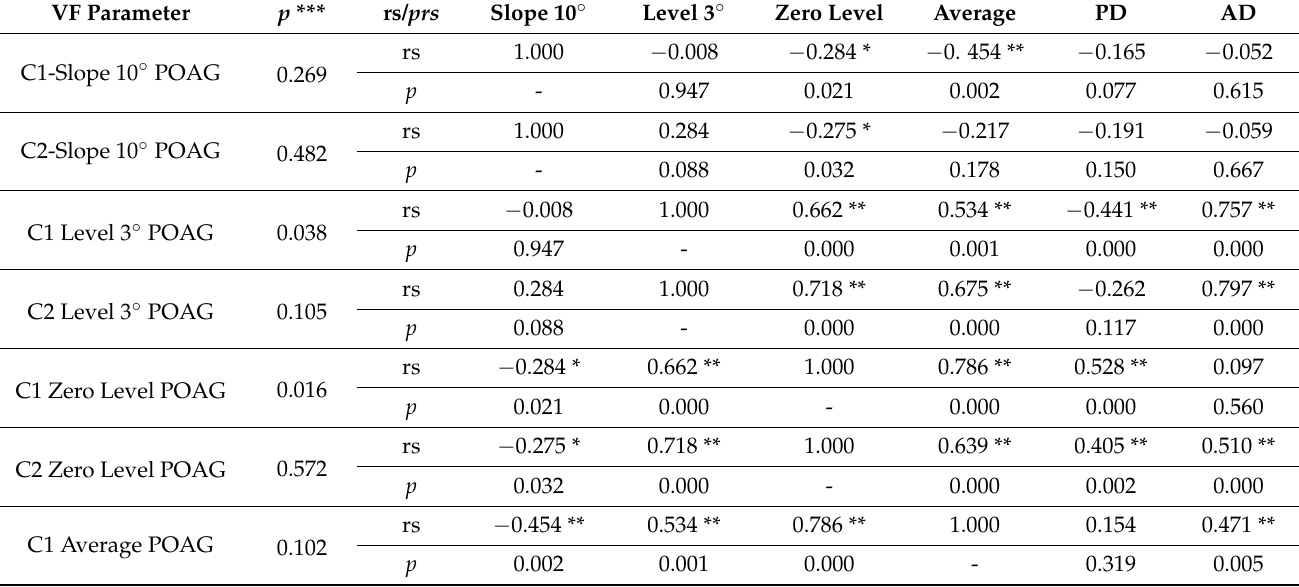
Table 8. Comparative distribution of correlations between “Visual Field” parameters in patients with POAG at the first consultation (VF1) and at the last consultation